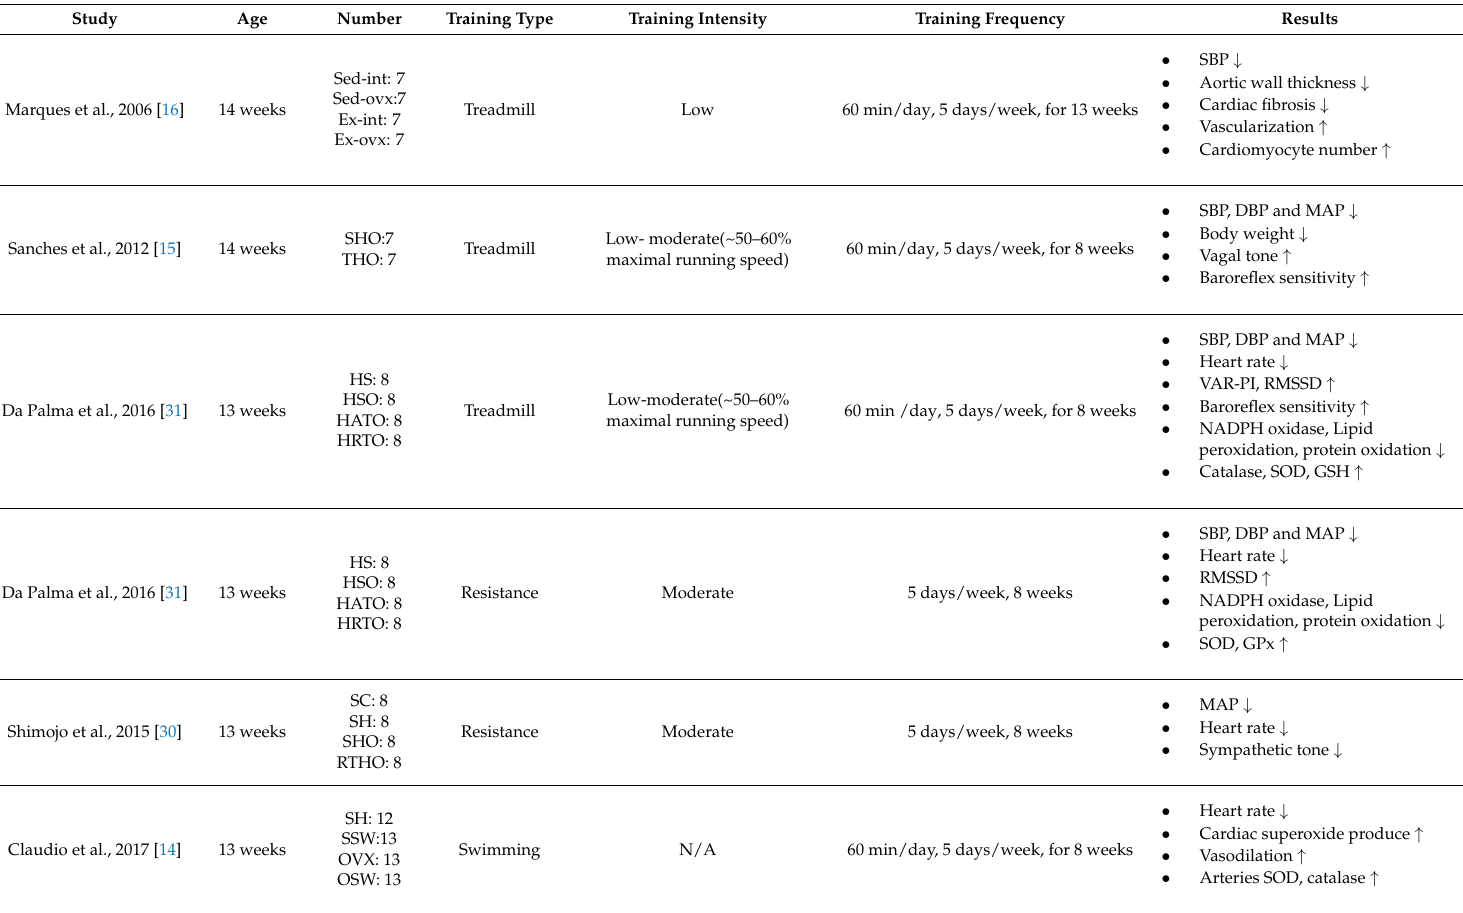
Table 2. Summary of exercise training protocols and outcomes from ovariectomized hypertensive animals